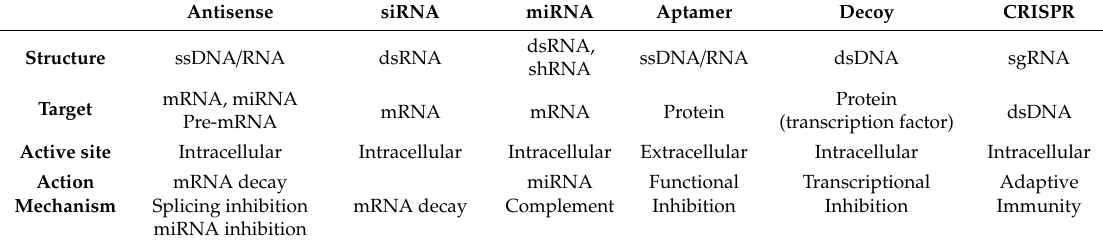
Table 2. Classification of oligonucleotide therapeutics.